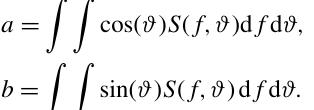
Table A1. The n th-order moment of the spectral density function, m n , referred to in the table is defined as m n = (cid:82) (cid:82) f n E ( f,ϑ )d f d ϑ . Directional Fourier coefficients a and b used to compute the wave directional spreading are as fol-